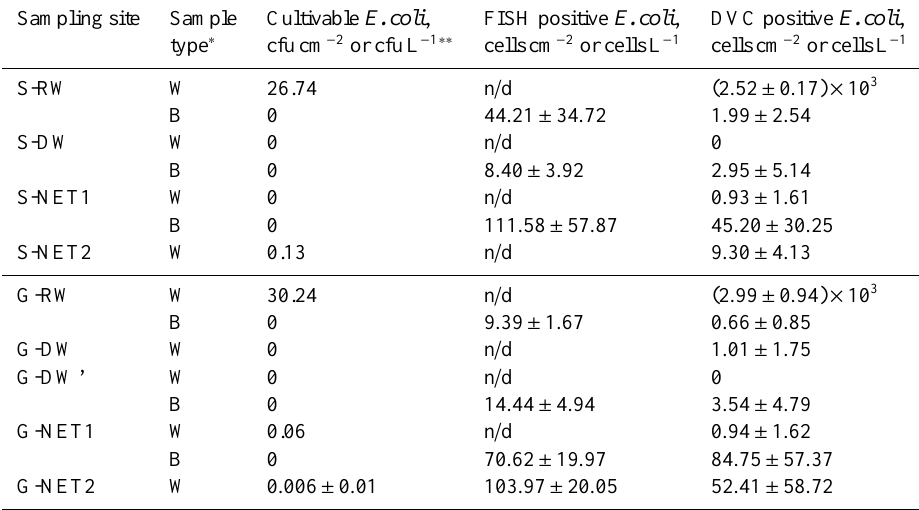
Table 1. Total cultivable, FISH positive and DVC positive (viable) Escherichia coli in the biofilm and water samples. Values are the average for four seasons with standard deviation specified as a maximum and minimum